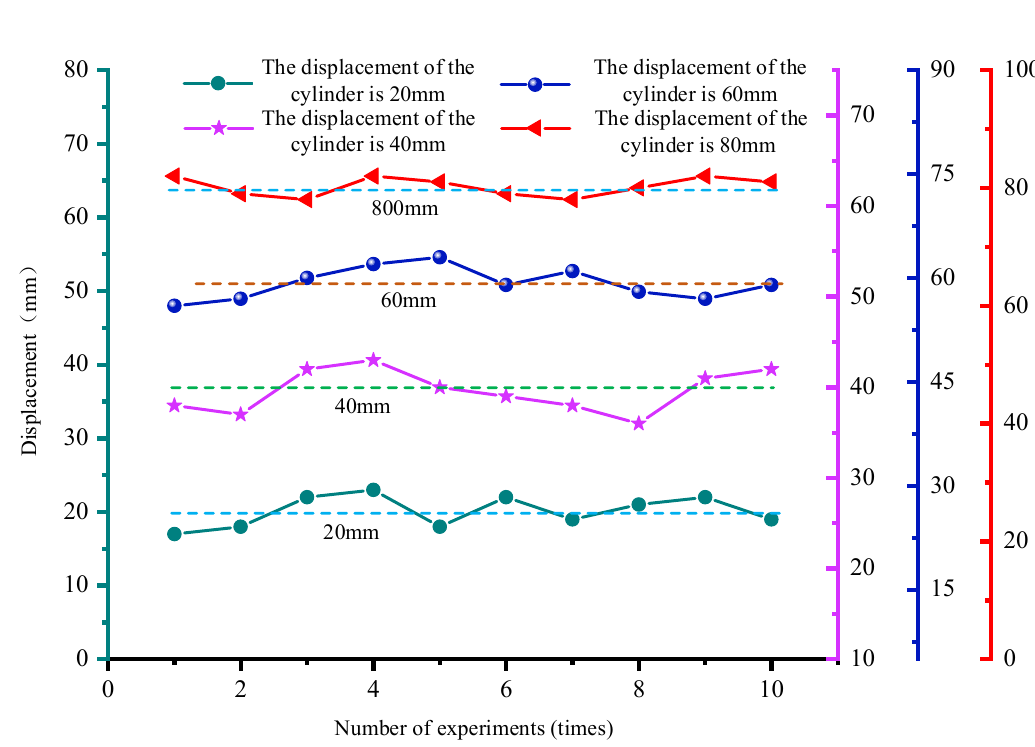
Figure 25. Displacement curve of the balancing cylinder of hydraulic support.